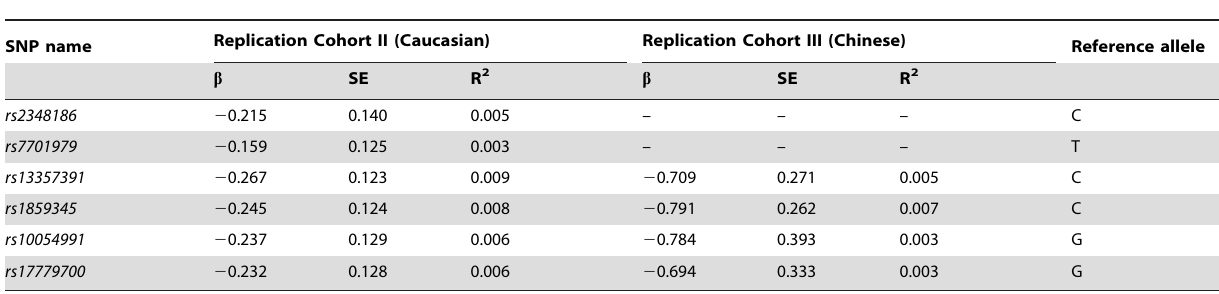
Table 4. Magnitude and direction of SNP effects in Replication Cohorts II and